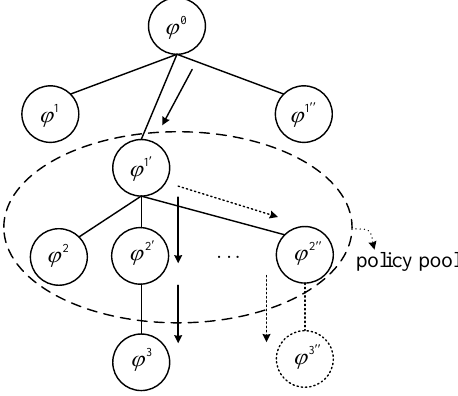
Figure 2. Incremental clustering and expansion (ICE) search tree. Due to inappropriate policy pruning, some nodes like ϕ 2 (cid:48)(cid:48) will be left in the policy pool and they may be still expanded in later iterations. The dashed circle is an unvisited